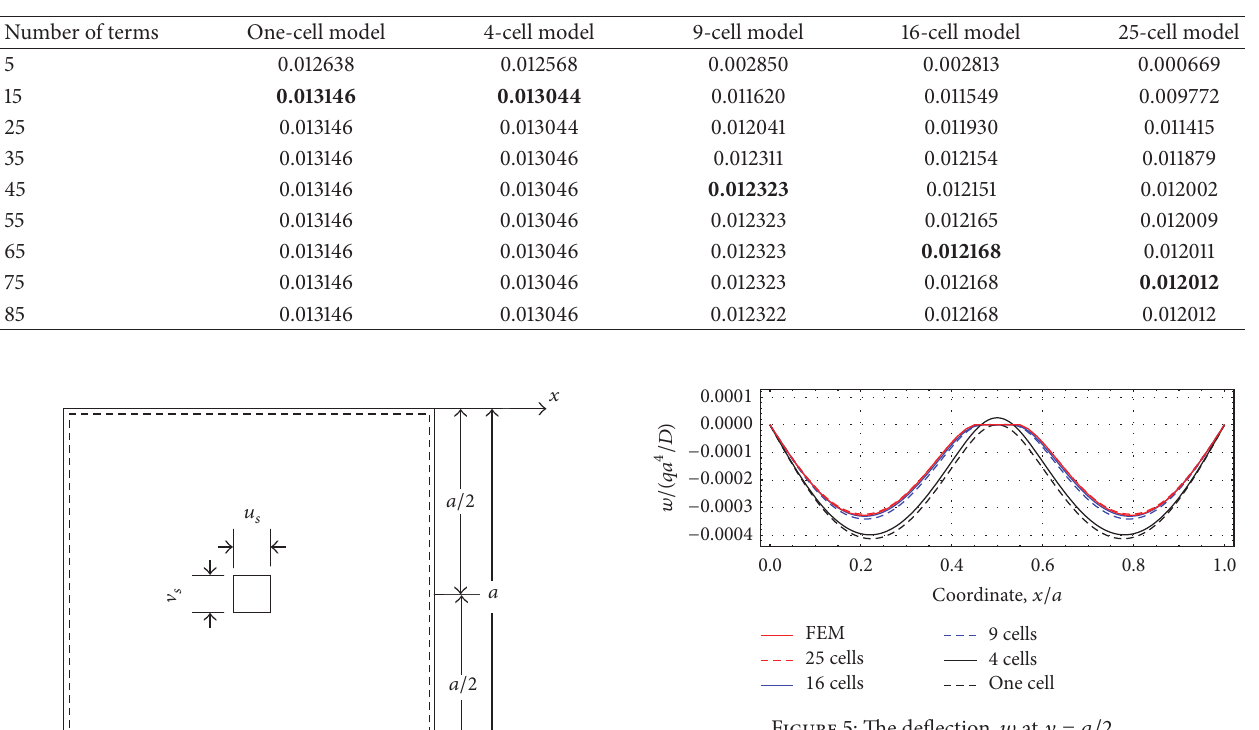
Figure 5: The deflection, 𝑤 at 𝑦 = 𝑎/2 .